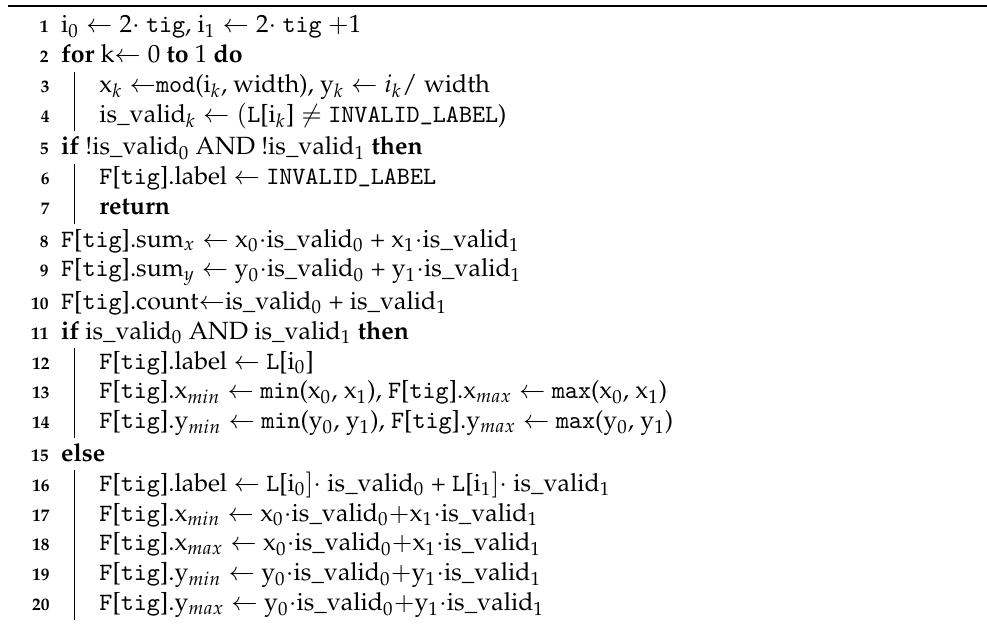
Algorithm 1: initialize( F , L ,